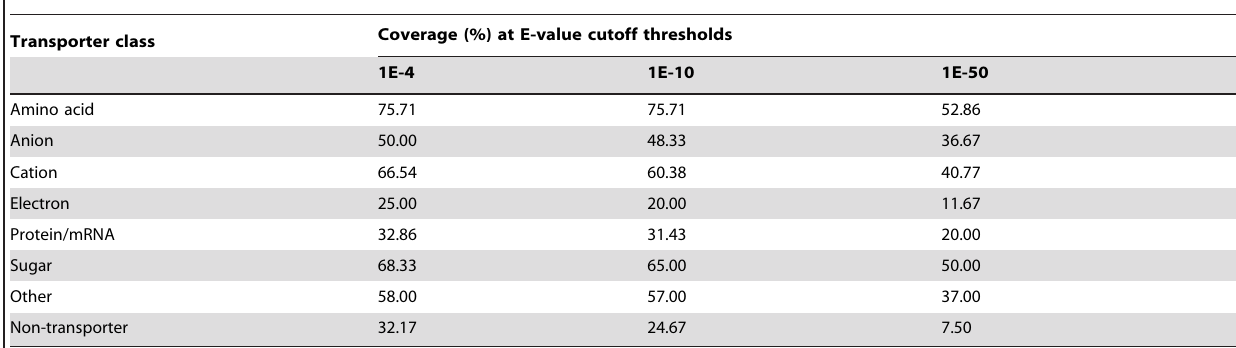
Table 6. The performance (coverage metric) of the BLAST search on the main dataset using the standard five-fold cross-validation.